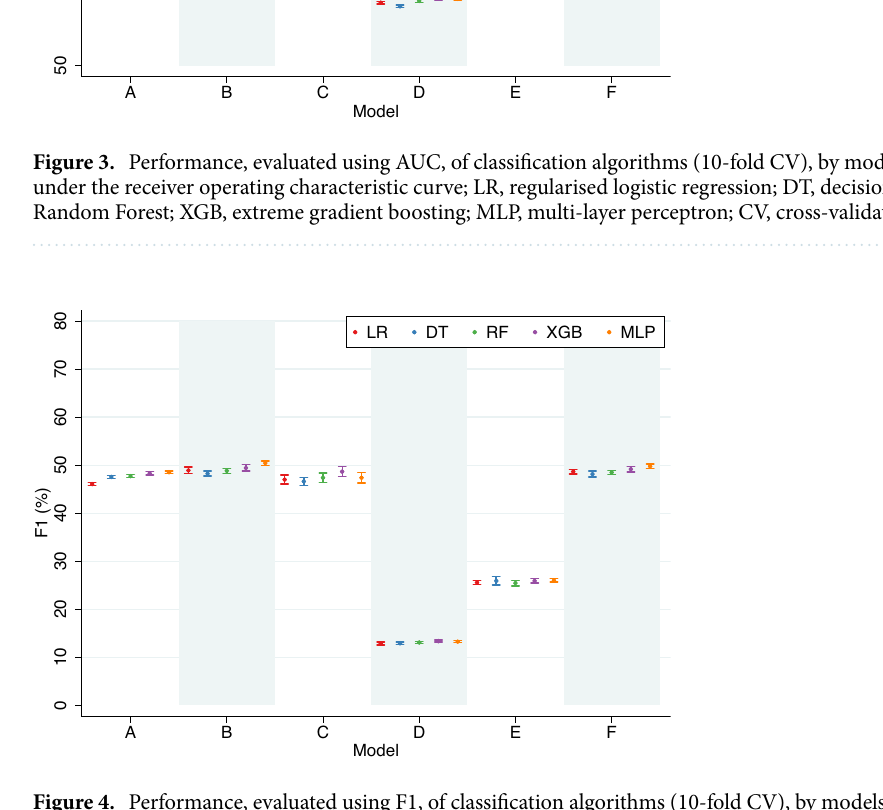
Figure 4. Performance, evaluated using F1, of classification algorithms (10-fold CV), by models. F1, F1 score; LR, regularised logistic regression; DT, decision trees; RF, Random Forest; XGB, extreme gradient boosting; MLP, multi-layer perceptron; CV,